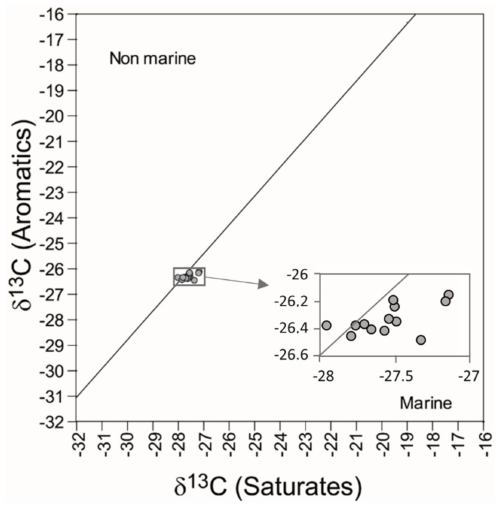
Figure 3. Sofer isotope diagram for the aromatic and saturated hydrocarbons of thirteen representative oil